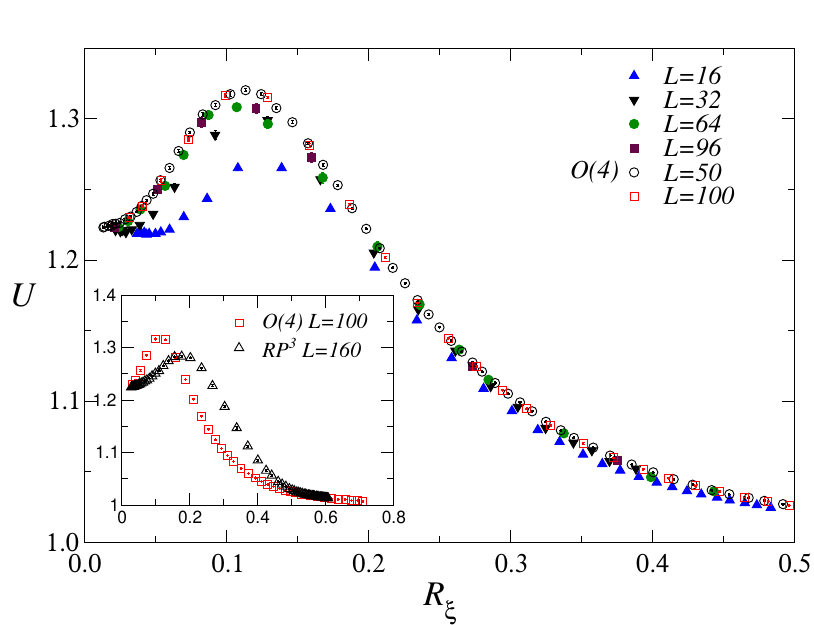
Figure 6 . Plot of U versus R ξ for N c = 2 , N f = 4 , γ = 0 , and v = 10 . Data are compared with analogous results for the spin-2 operator computed in the lattice O(4) σ model with action (3.19). For comparison, we also report data for the 2D RP 3 model